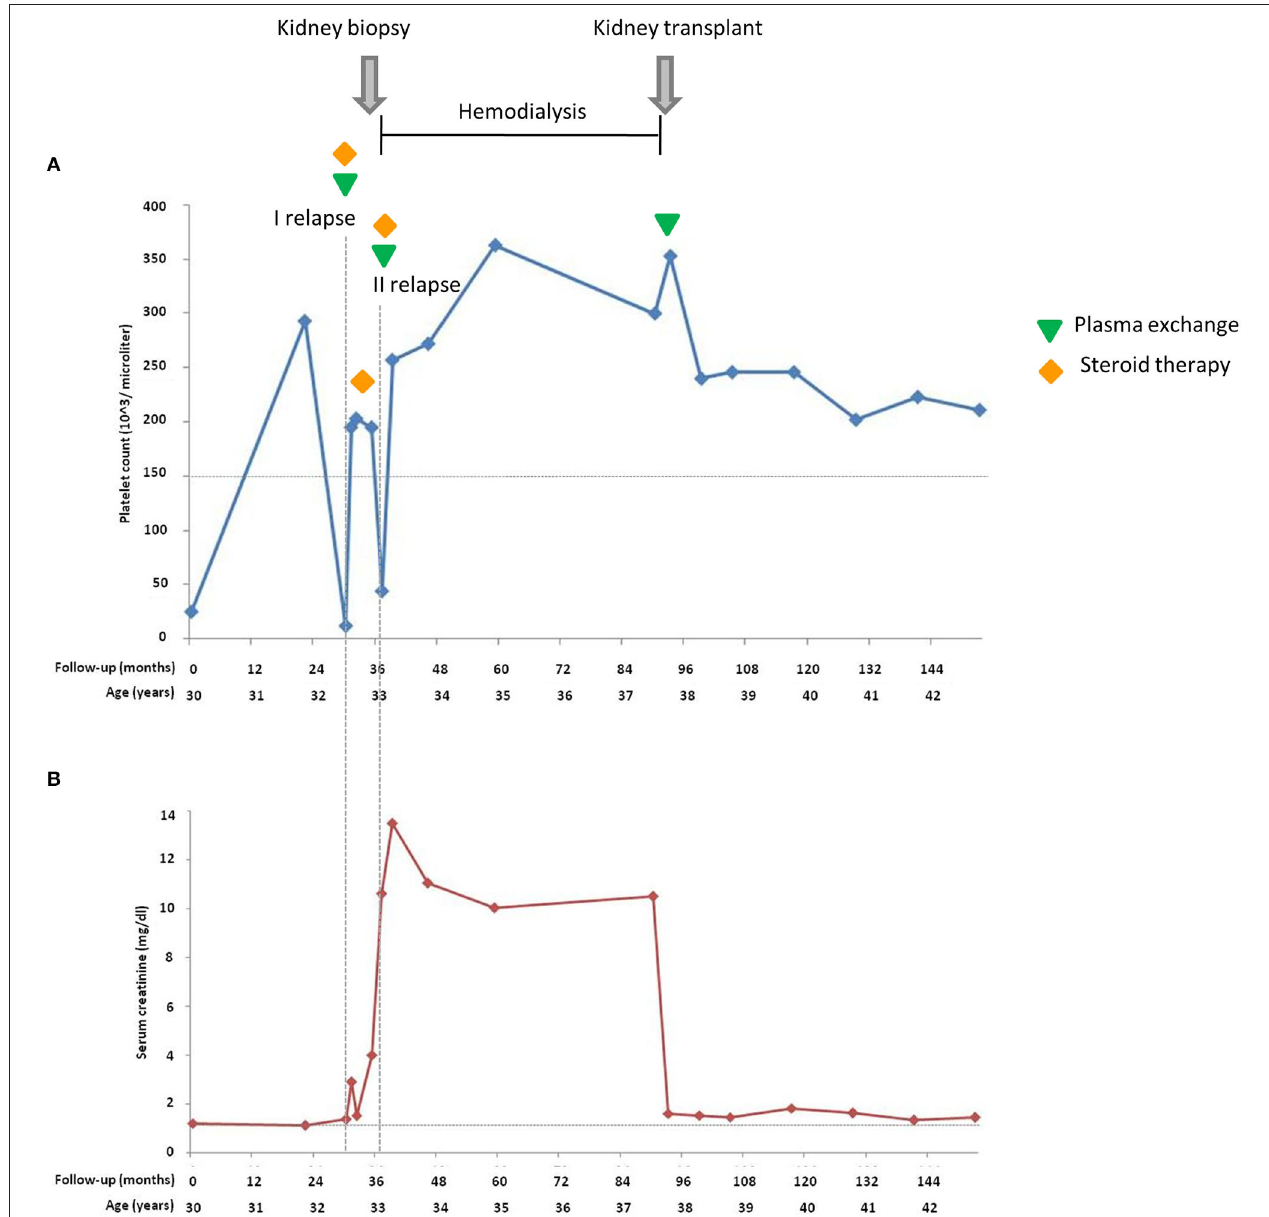
FIGURE 2 | Platelet count (A) and serum creatinine (B) of the proband during 153 months of follow-up from the atypical hemolytic uremic syndrome (aHUS) onset. Horizontal dashed lines in (A) indicate the lower limit of normal platelet count (150,000/ µ l); in (B) indicate the upper limit of the normal serum creatinine range. Vertical dashed lines highlight the two